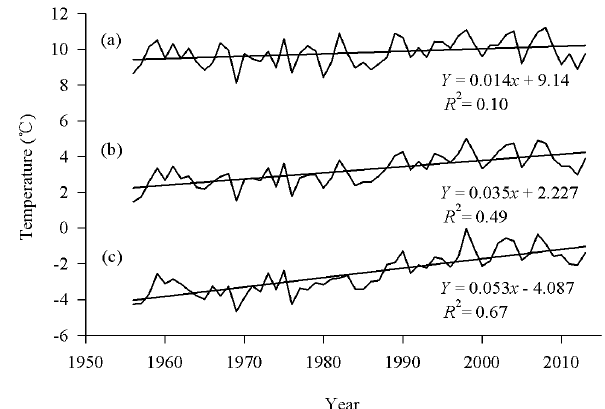
Figure 5. Interannual variation of the mean maximum (a) , mean (b) , and mean minimum temperatures (c) from 1956 to 2013. The straight line represents the fitted trend